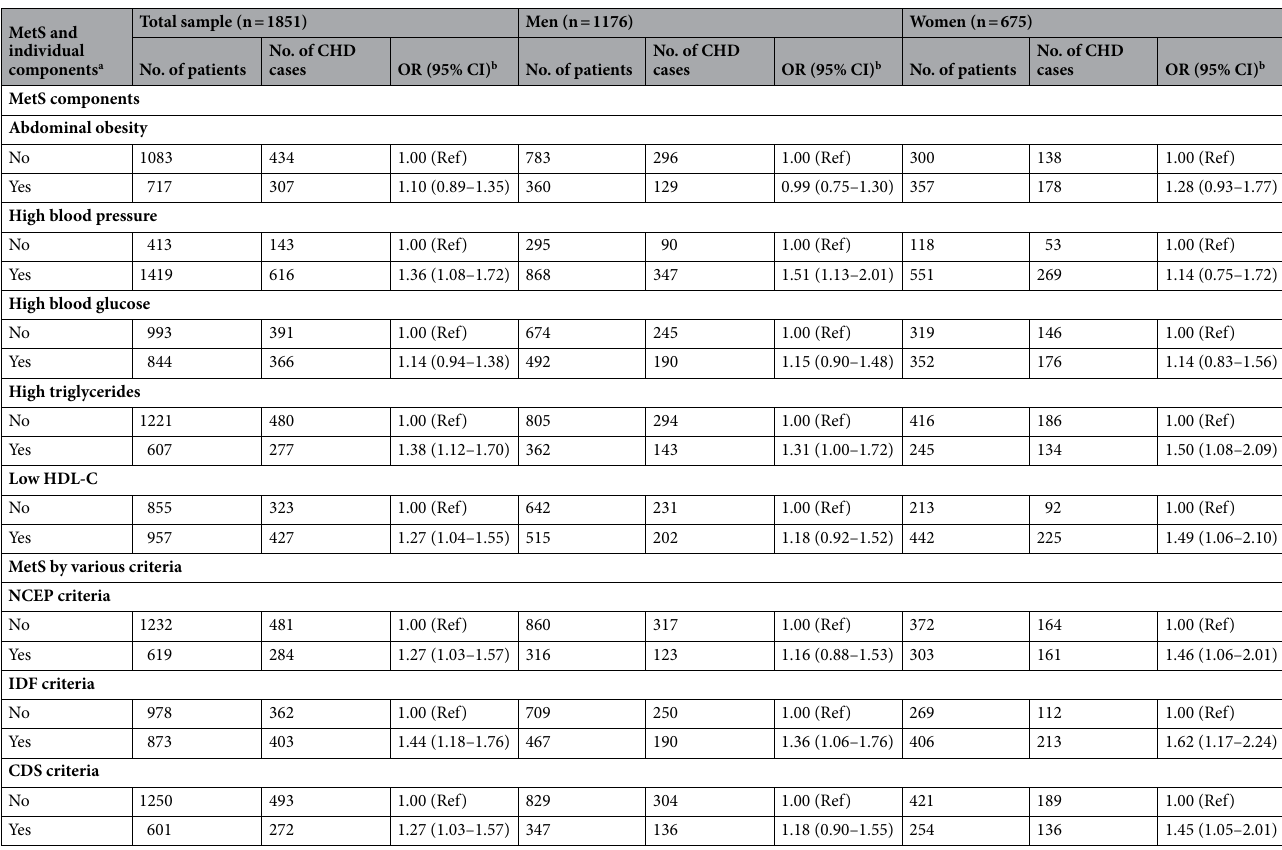
Table 3. The associations of metabolic syndrome and its individual components with coronary heart diseases in patients with acute ischemic stroke. MetS Metabolic syndrome, HDL-C high-density lipoprotein cholesterol, CHD coronary heart disease, OR odds ratio, CI confidence interval, NCEP National Cholesterol Education Program, IDF International Diabetes Federation, CDS Chinese Diabetes Society. a The individual components were defined according to the IDF criteria. The number of participants with missing values was 51 for abdominal obesity, 19 for high blood pressure, 14 for high blood glucose, 23 for high triglycerides, and 39 for low HDL-C. b OR (95% CI) was derived from models that were controlled for age, education, smoking, alcohol drinking, physical inactivity, and dietary, and if applicable, for